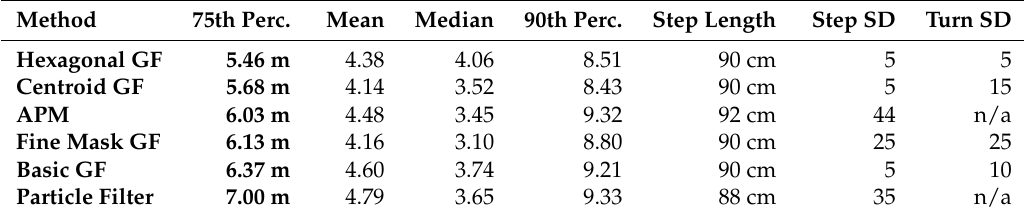
Table 6. The best results for considered methods on the IPIN 2018 on-site competition track. The mean, median, and 90th percentile are listed together with the third quartile of errors on 70 checkpoints. Method 75th